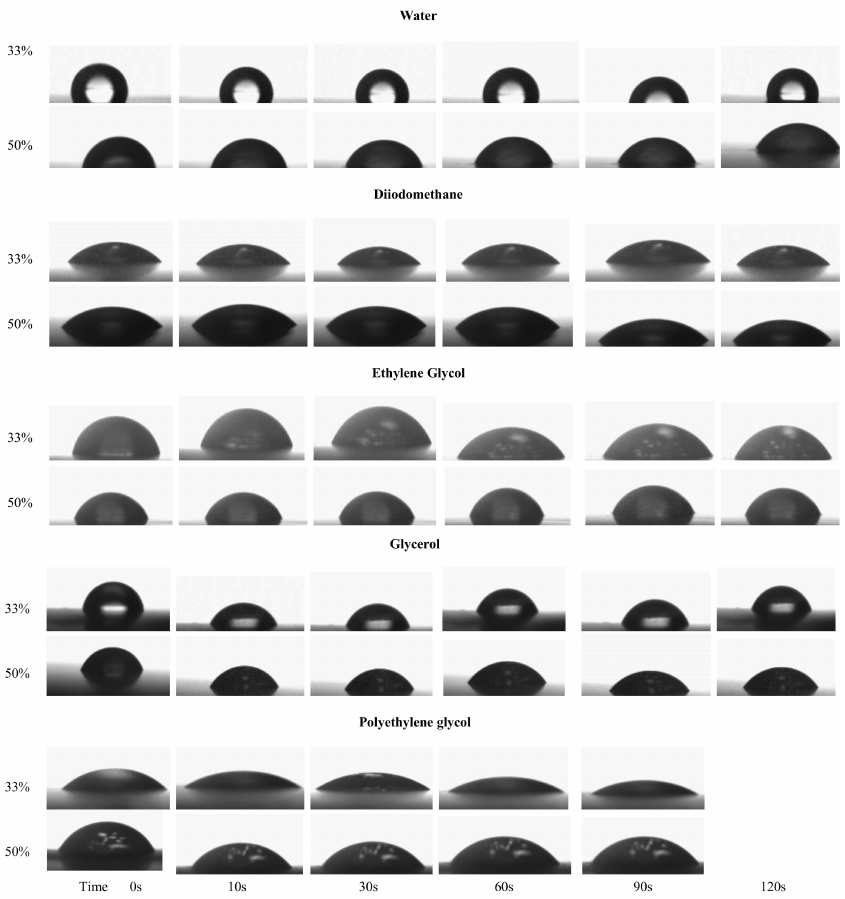
Figure 5. Behavior of water, diiodomethane, ethylene glycol, glycerol, and polyethylene glycol droplets on film surfaces as a function of time for starch films with 33% and 50% of